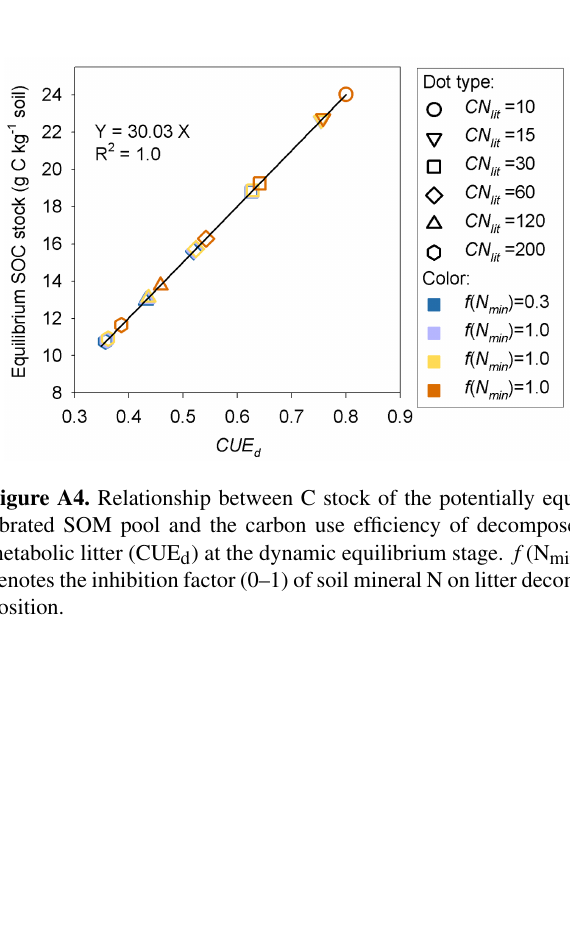
Figure A3. Dynamic of the simulated carbon use efficiency (CUE) and f ( N min ) during the incubation experiments (Table A4). CN lit is the C:N ratio of incubated litter, and N min is the initial soil min- eral N concentration (gNkg − 1 soil). M0–M3 are the four models in Table 1. Here, the simulation results of each model were calcu- lated with parameters optimized based on all of the 14 samples of incubation experiments (Table A2).